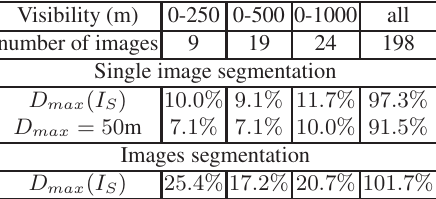
Table 1: Mean relative error between the estimated visibility dis- tance and the ground-truth on the Matilda database for different distance ranges, with a single image segmentation. The first line is obtained from the maximum distance D max where I S is ob- served and the second line is for a shorter and fixed distance D max = 50 m. On the last line, the segmentation is computed a moving